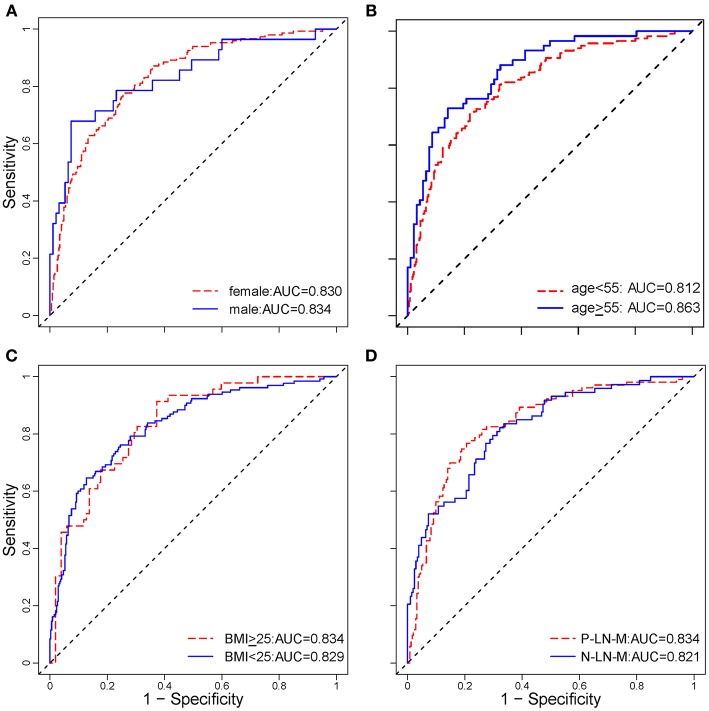
Stratified analysis of the radiomic nomogram in different subgroups. Stratified analysis for ETE in patients with PTC according to sex (A), age (B), BMI (C), and LN metastasis status (D). The age cut-off was based on the National Comprehensive Cancer Network (NCCN) Guidelines for thyroid carcinoma (Version 3. 2018). These analyses demonstrated that the radiomic nomogram had good and similar discriminations for predicting ETE status in patients with PTC in different subgroups. ETE, extrathyroidal extension; PTC, papillary thyroid carcinoma; AUC, area under receiver operating characteristic curve; BMI, body mass index; P-LN-M, positive lymph node metastasis; N-LN-M, negative lymph node metastasis.